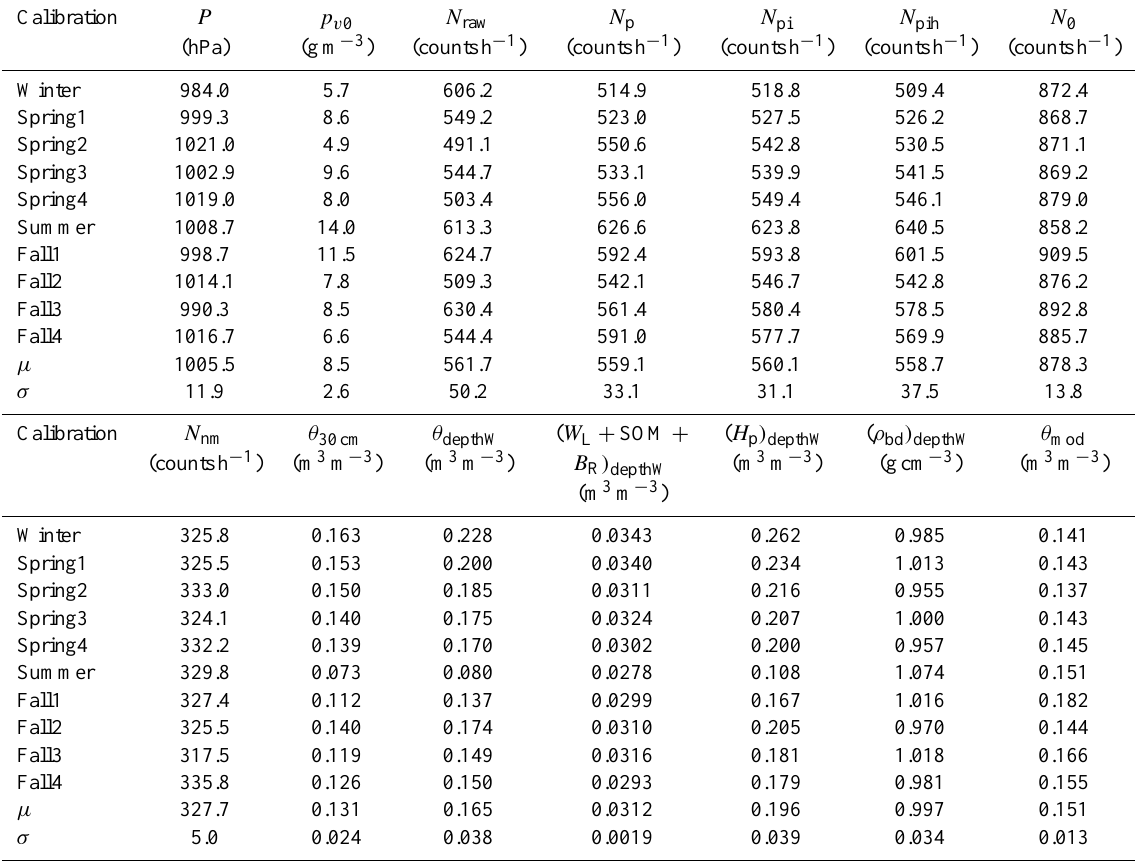
Table 4. Atmospheric and soil parameters as well as neutron counts for the 10 calibrations. Atmospheric pressure P , absolute